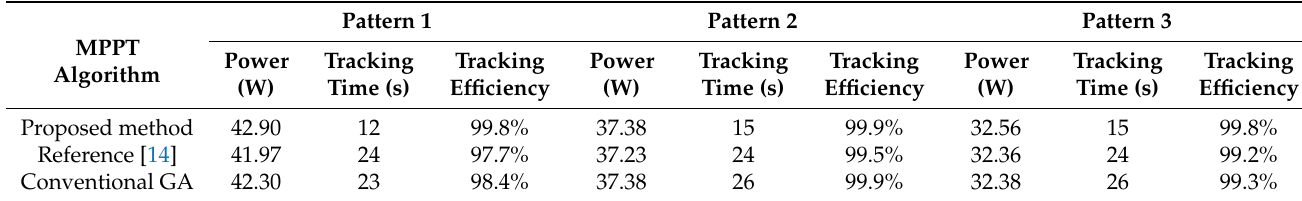
Table 5. Experimental results for Patterns 1–3.